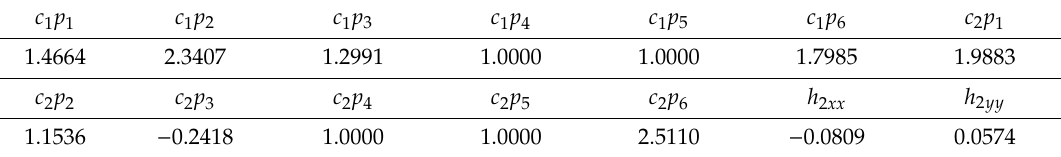
Table 8. Parameters of the extended Drucker potential function for AA 2009-T3 sheet.